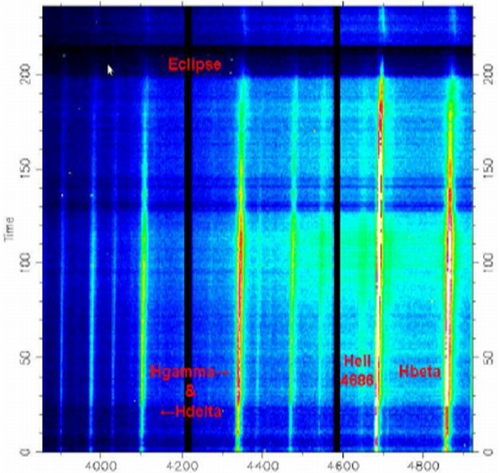
Figure 6: An example of time resolved (10s) trailed spectroscopy of the eclipsing polar HU Aqr.